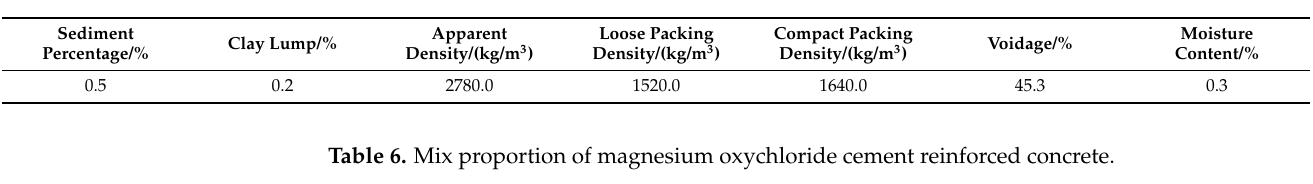
Table 5. Performance index of gravel.